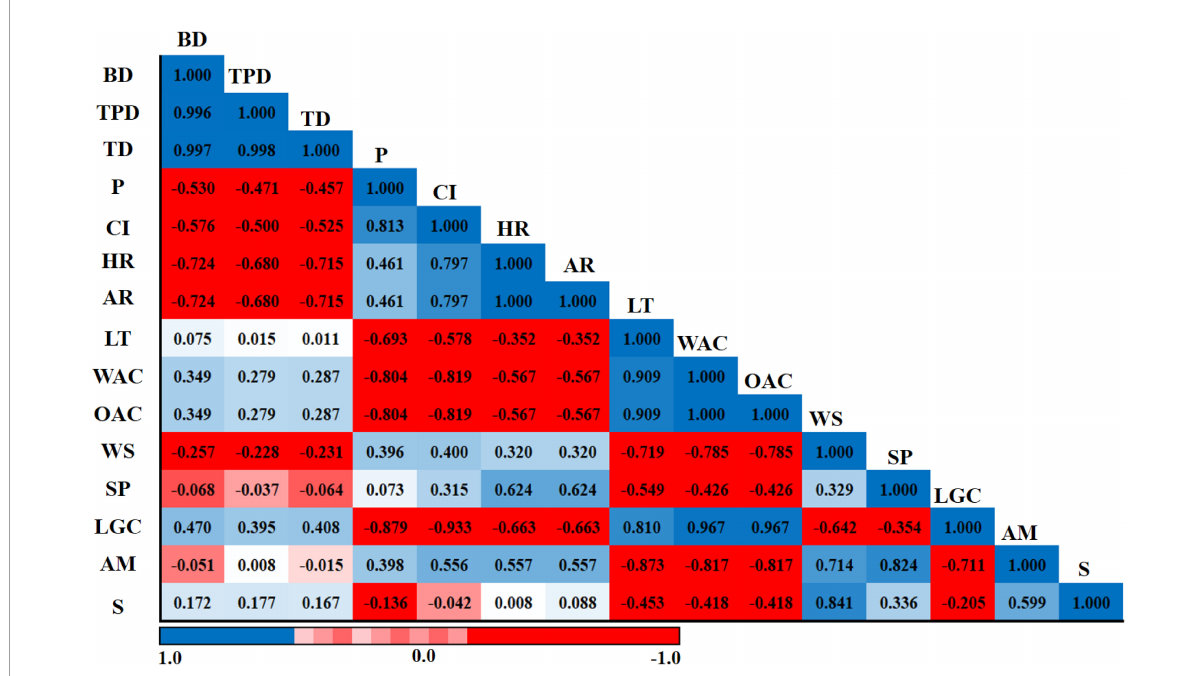
FIGURE6 Pearson’s correlation coefficients of amylose, starch, physical properties, micrometric properties, and functional properties of six sorghum grains. BD, bulk density; TPD, tapped density; TD, true density; P, porosity; CI, Carr’s index; HR, Hausner’s ratio; AR, angle of repose; LT, light transmittance; WAC, water absorption capacity; OAC, oil absorption capacity; WS, water solubility; SP, swelling power; LGC, least gelation concentration; AM, amylose; S, starch. The numbers in each field represent the correlation extent; the color represents significant correlation ( p < 0.05); the deeper the color of the field, the more significant the correlation ( p < 0.01). The blue color means a positive correlation, and the red color means a negative